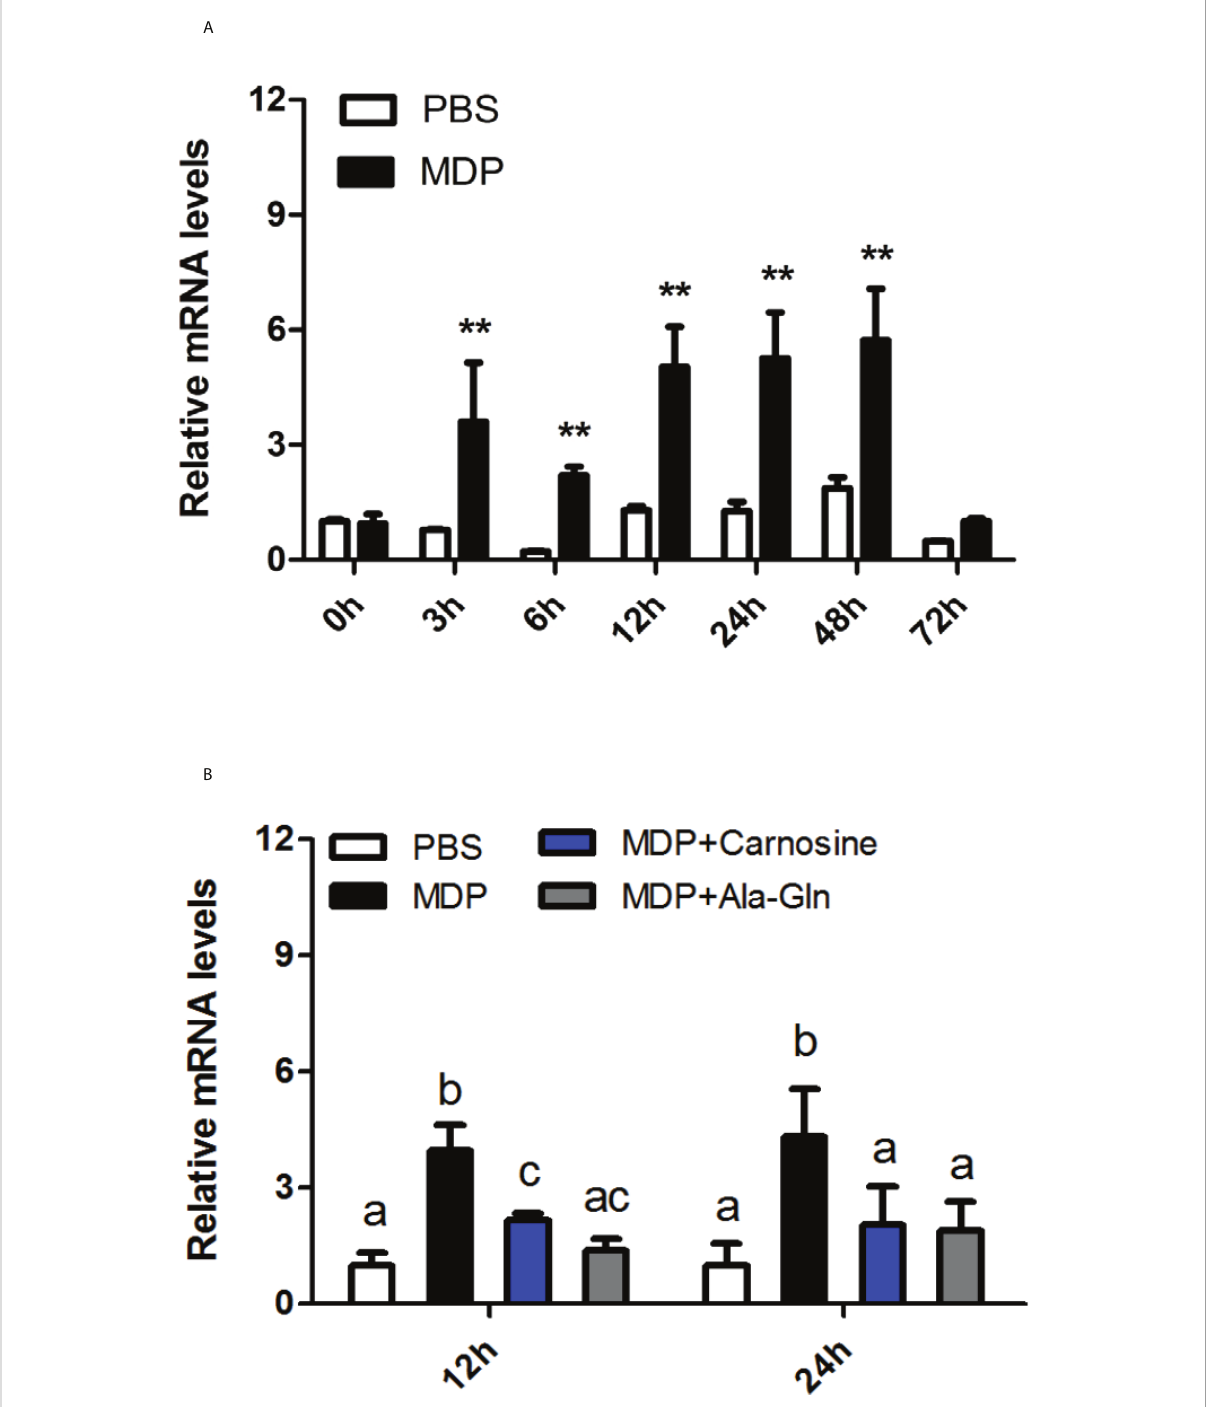
FIGURE 9 Temporal expression pro fi les of Ci MEKK3 mRNA in the intestine after injection with MDP (A) or MDP + carnosine/Ala-Gln (B) . Comparative analysis and statistical tests were performed on the challenge groups and PBS group at the same time point. Each bar represents the mean of the normalized expression levels of replicates ( N = 3). Signi fi cant differences are indicated with an asterisk (** represents P < 0.01) or different letters ( P <